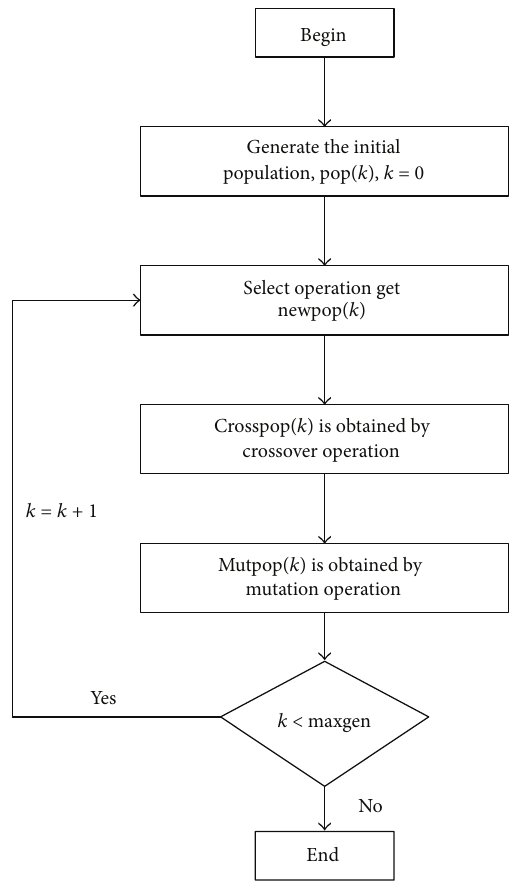
Figure 1: The flow chart of genetic algorithm iteration.